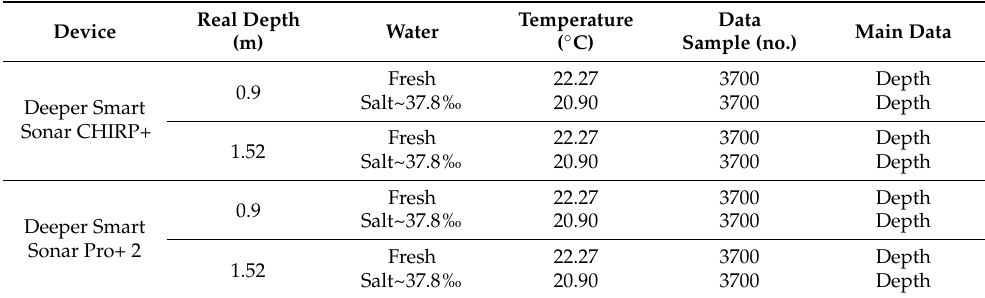
Table 6. Water depth datasets